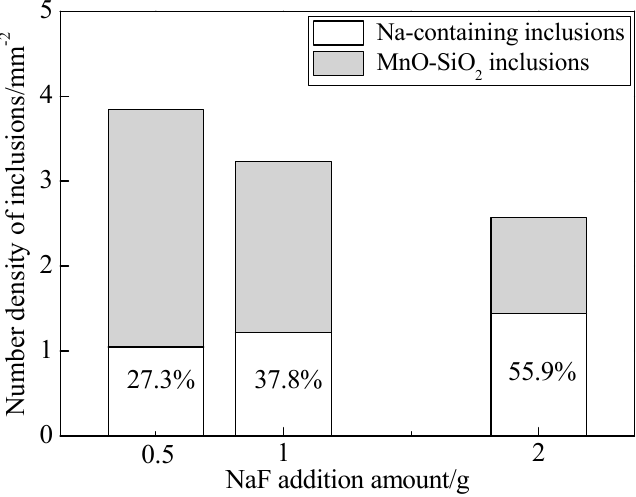
Figure 8. Relationship between inclusion quantity and NaF addition.